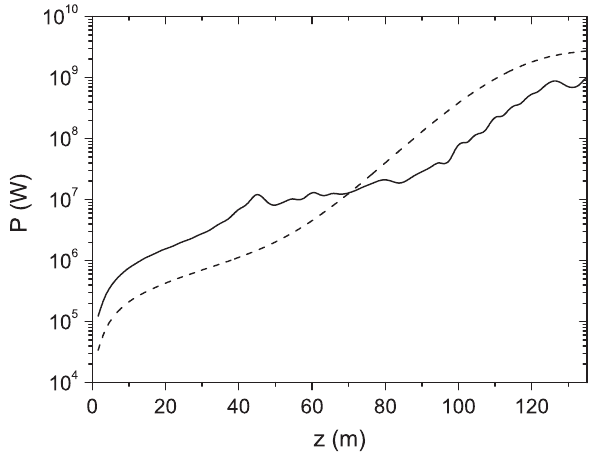
FIG. 8. An example for the European XFEL. Averaged peak power for the fundamental harmonic (solid) and the third har- monic (dash) versus magnetic length of SASE1 undulator. The wavelength of the third harmonic is 0.2 A ˚ (photon energy 62 keV). The fundamental is disrupted with the help of phase shifters installed after 5 m long undulator segments. The phase shifts are 4 (cid:1)= 3 after segments 1–8 and 21–26, and 2 (cid:1)= 3 after segments 9–16. Simulations were performed with the code FAST